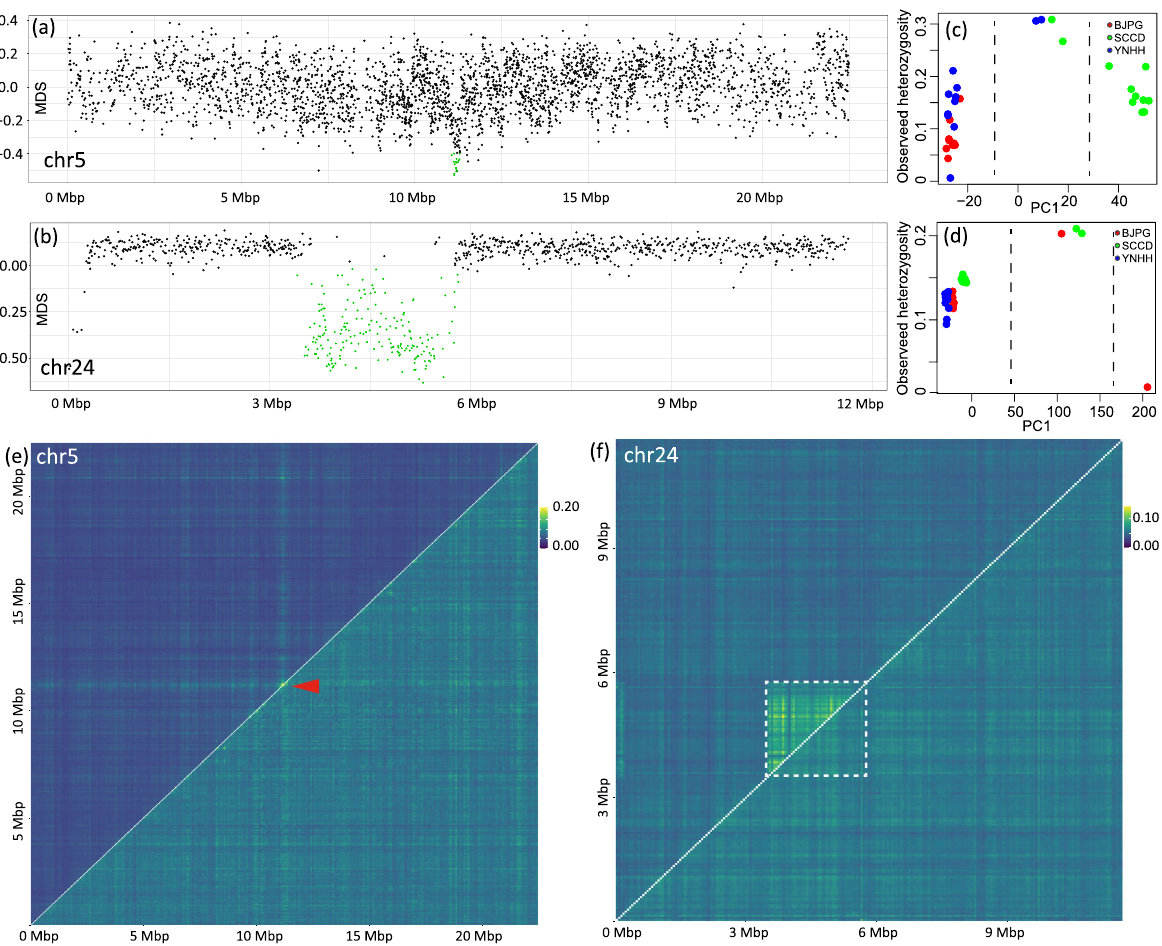
Fig. 5 Genome inversions identi fi ed in the Grapholita molesta . a , b Local PCA output for putative inversion region of chromosome chr5 and chr24. MDS, multidimensional scaling. Dots represent multidimensional scaling (MDS) for 100 SNP windows; outlier windows are highlighted in green. c , d Plots of the fi rst component of a PCA and observed heterozygosity for the inversion regions of chromosome chr5 ( c ) and chr24 ( d ). e , f Heatmap of pairwise linkage disequilibrium for 50 kbp windows for chromosome chr5 ( e ) and chr24 ( f ); the upper triangle shows the linkage disequilibrium values for all individuals, while the lower triangle shows the linkage disequilibrium values when individuals have chromosomal inversion were excluded; the red arrow points to the small inversion region in chr5 ( e ), while the white box shows the large inversion region in chr24 ( f